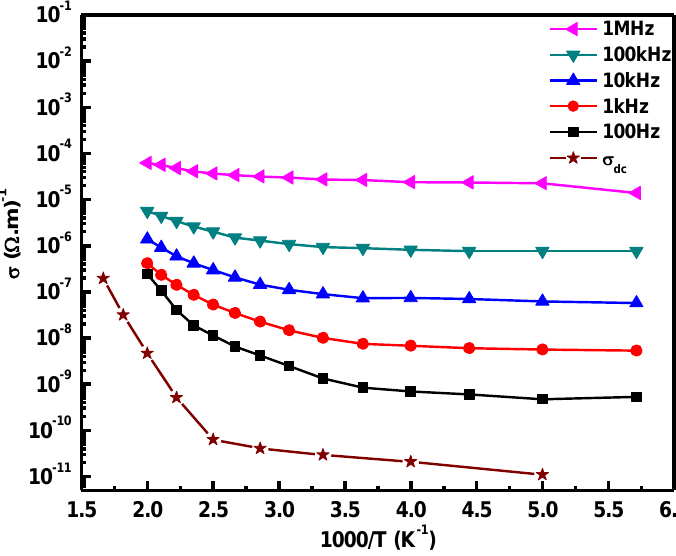
Figure 6. The AC and DC electrical conductivity of LaGdO temperature. Reprinted with permission from [15]. Copyright 2012 AIP Publishing LLC.